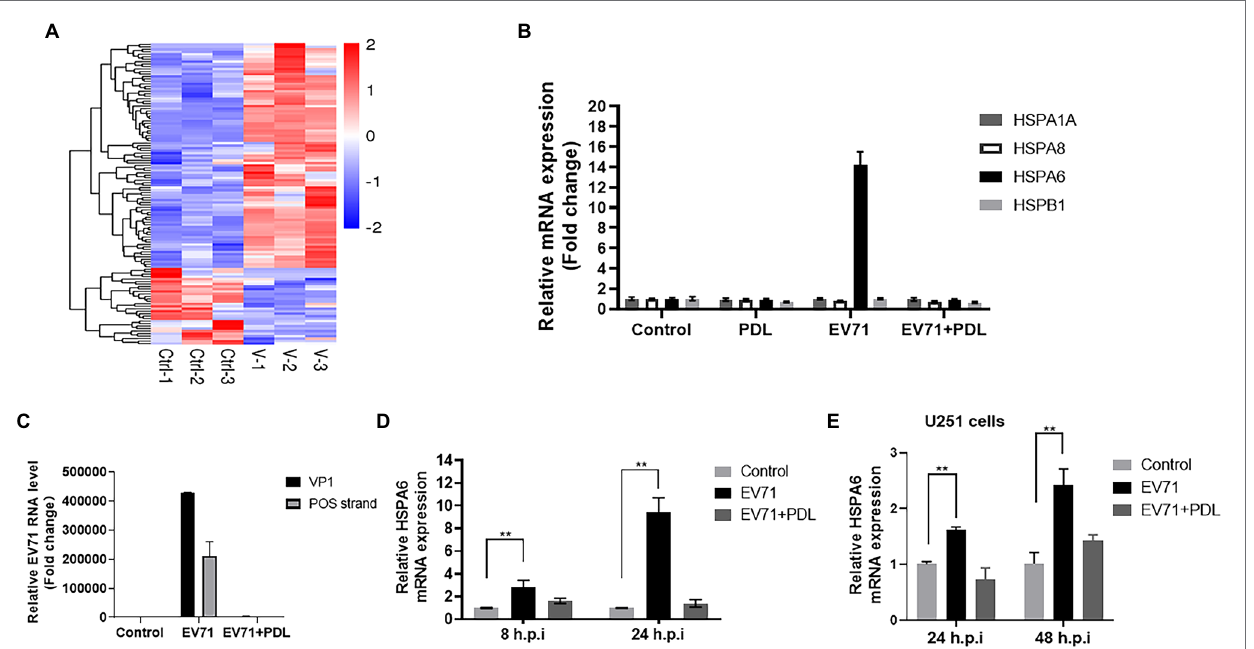
FIGURE 1 | EV71 infection specially upregulates HSPA6 gene expression. (A) Heat map of RNA-Seq transcriptome analysis for genes changed in RD cells infected with EV71 for 8 h. (B) RT-PCR measurement of HSPA6 and HSPA1, HSPA8, and HSPB1 expression in RD cells infected with EV71 for 8 h. (C) RT-PCR measurement of EV71 VP1 gene and positive (POS) strand in RD cells infected with EV71 for 8 h. (D) RT-PCR measurement of HSPA6 expression in RD cells infected with EV71 for 8 h and 24 h. (E) RT-PCR measurement of HSPA6 expression in U251 cells infected with EV71 for 24 h and 48 h. Control presented cell control, and PDL presented treating the cells with 10 μ M of pendulectin at the same time of EV71 infection (** p <